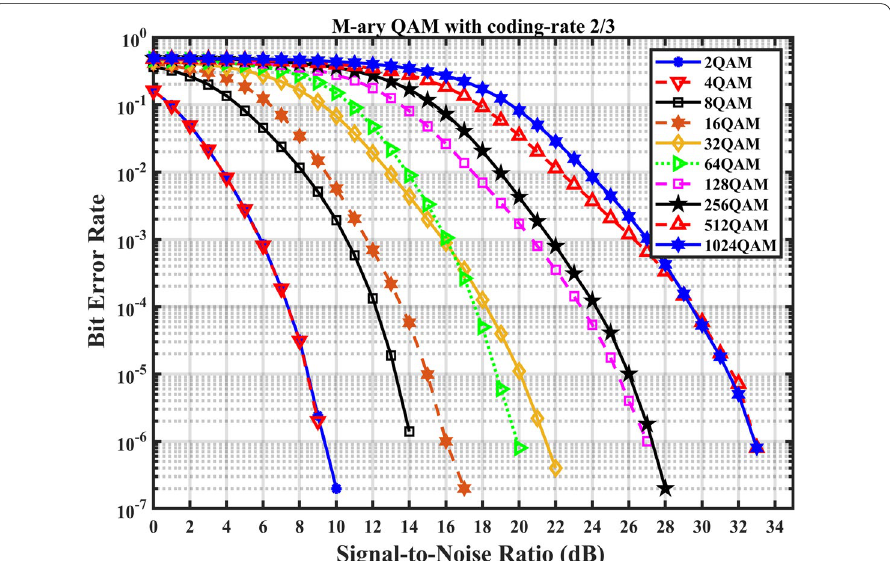
Fig. 13 BER versus SNR for different M-ary QAM with 2/3 code rate. This graph depicts the performance of different M-ary QAM with 2/3 code rate combination. The performance is described in terms of BER